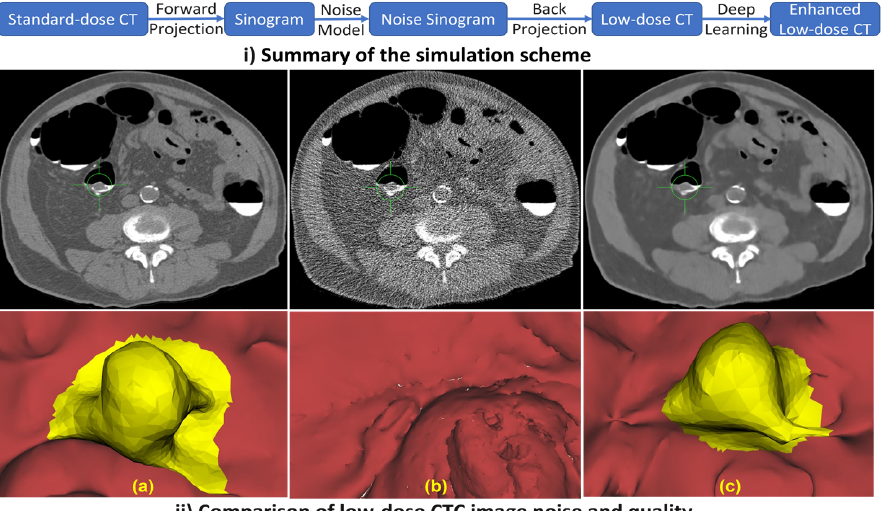
Figure 7. A patient with a 1.7 cm pedunculated polyp in the sigmoid colon. ( a ) Standard-dose CT is scanned (120 kVp/240 mAs). ( b ) Low-Dose CT is simulated using a noise insertion model (60 kVp). ( c ) Enhanced Low-Dose CT using FBP + U-Net back-projection approach